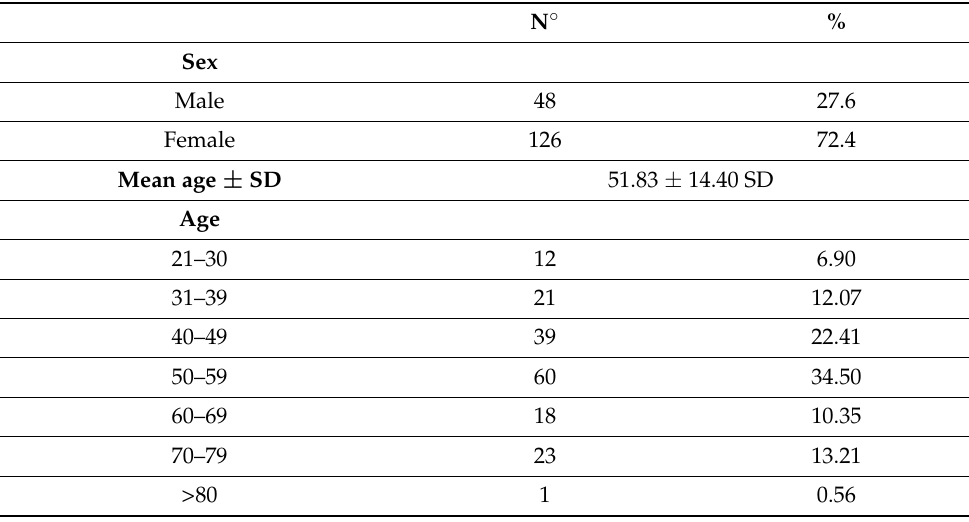
Table 2. Sociodemographic characteristics of the study sample (n =